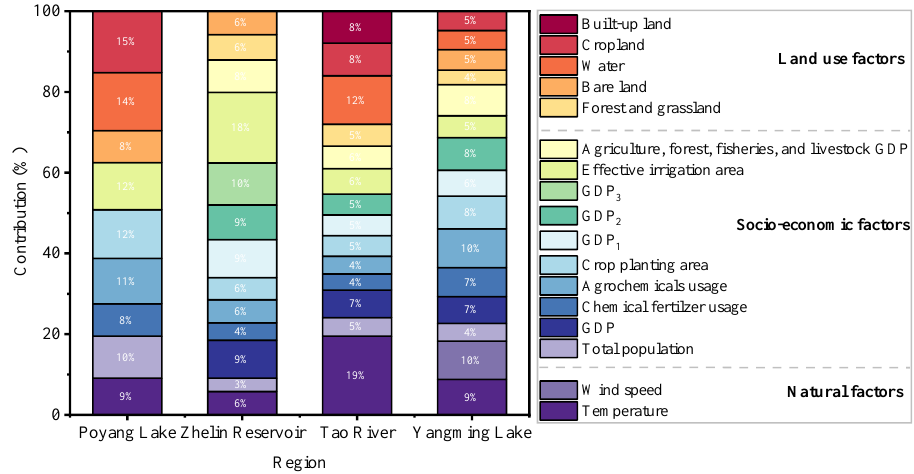
Figure 11. Contribution of drivers on spatial variation of water body eutrophication proportion in typical areas of Poyang Lake Basin using the entropy weight method.